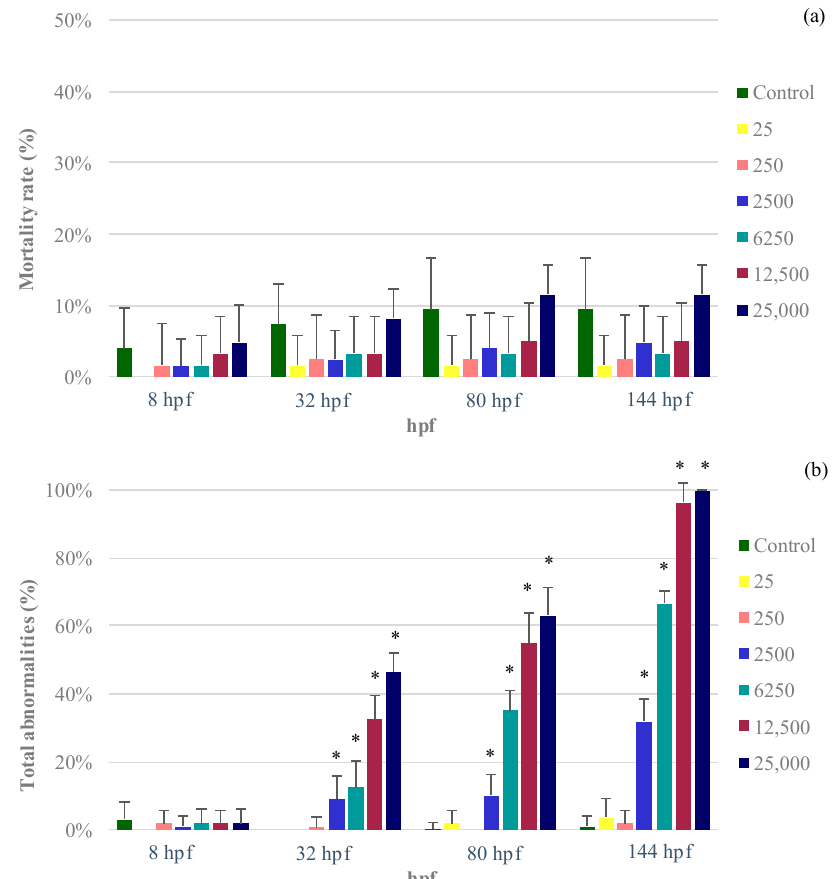
Figure 1. Mortality ( a ) and total abnormalities ( b ) observed for zebrafish embryos exposed to acetaminophen experimental solutions (25, 250, 2500, 6250, 12,500 and 25,000 µg L − 1 ) at the different observation times (8, 32, 80 and 144 h post fertilization (hpf)). Note: Mean results ( n = 12 for control; n = 6 for exposed groups) are shown together with standard error (SE). Results significantly different from control ( p ≤ 0.05) are marked with a symbol (*).